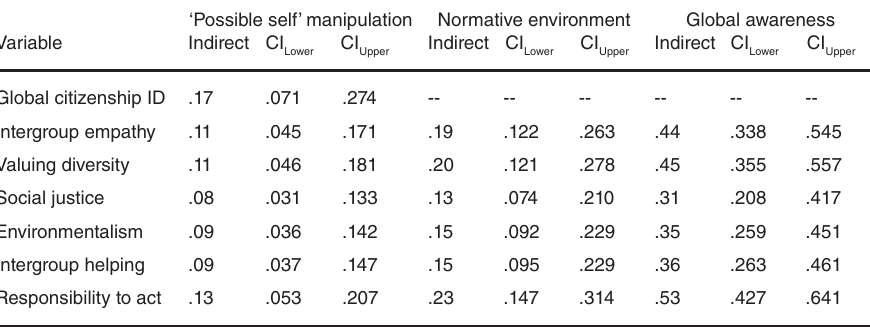
Table 4: Indirect effects of global citizen ‘possible self’ manipulation, normative environment, and global awareness Variable